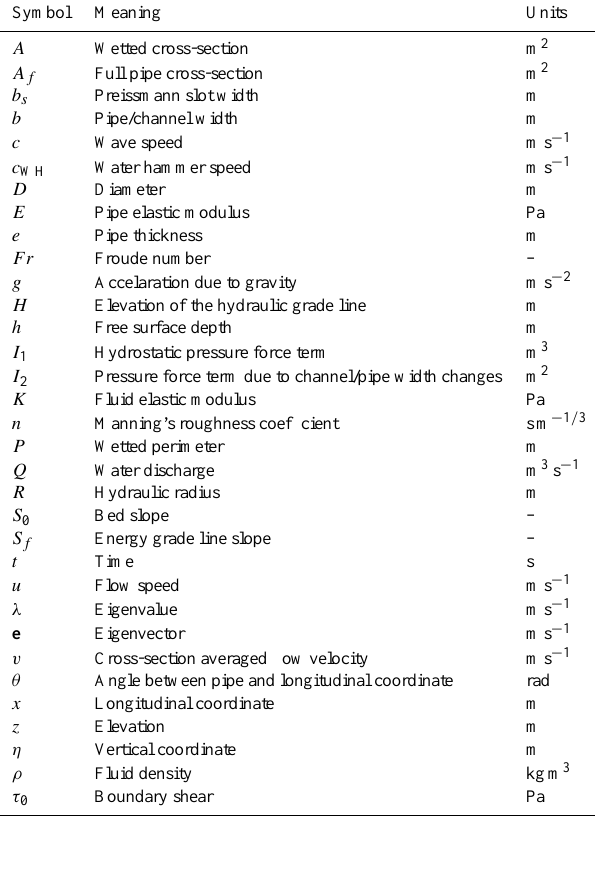
Table 1. List of symbols and